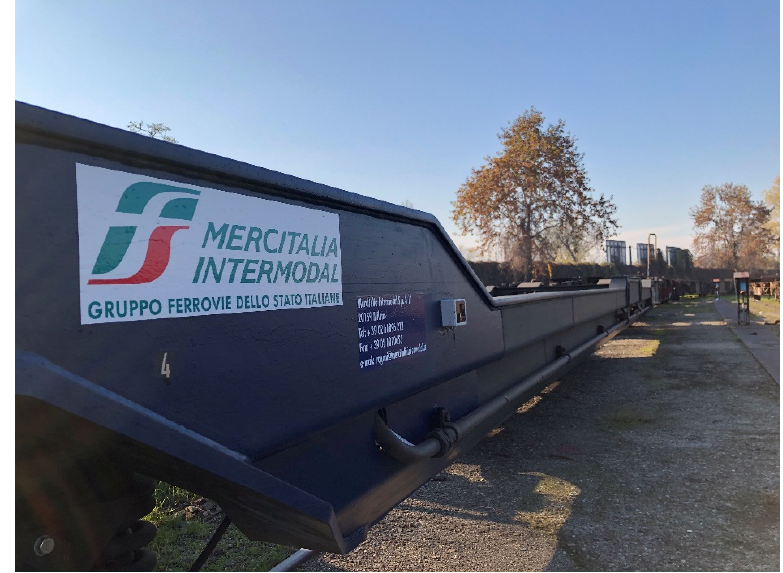
Figure 6. Mercitalia Intermodal T3000e freight wagon.